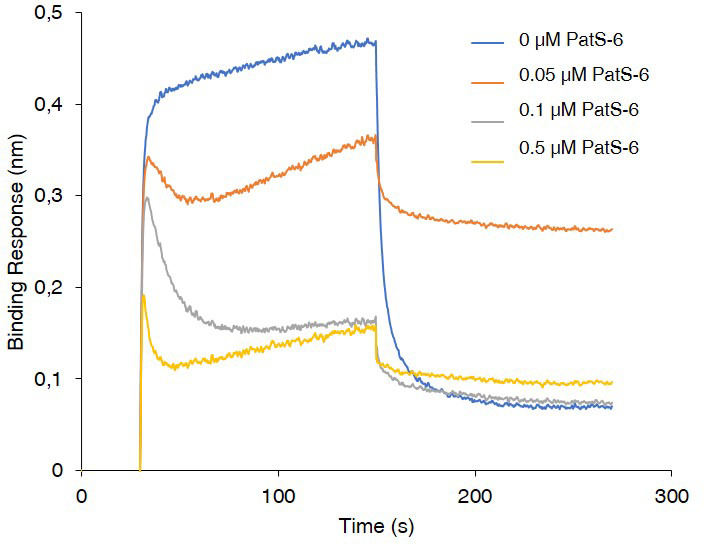
BLi assay between HetL and HetR in the presence of PatS-6.10 µM of HetL was incubated 5 min with different concentrations of PatS-6 at 0, 0.05, 0.1 and 0.5 µM before bringing HetL in contact with the bound HetR. Each curve represents the average of two experiments minus the control experiment. Control experiment HetL 10 µM loaded onto a biosensor devoid of HetR.Figure 2—figure supplement 2—source data 1.